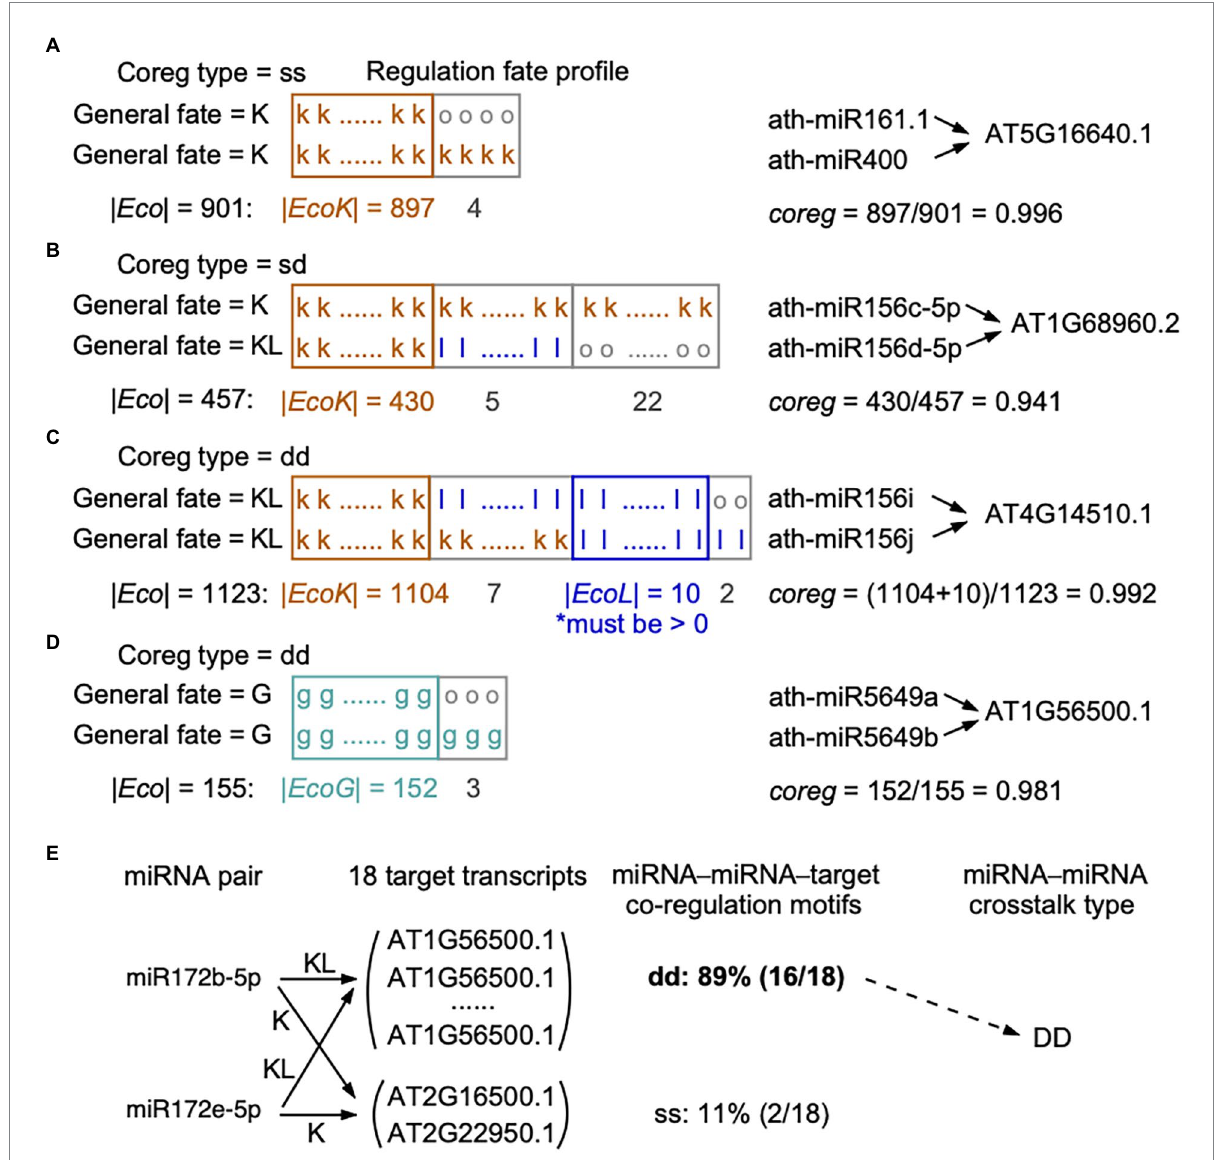
FIGURE 1 Calculation of co-regulation ( coreg ) score based on the regulation fate profiles. (A-D) Four different conditions for calculating coreg score were presented. When two miRNAs co-regulate a certain target in the reference genome, loss events in some ecotypes may happen (A) to none regulatory pairs (their general fates as “K” and “K”), (B) to only one regulatory pair (“K” and “KL”), or (C) to both regulatory pairs (“KL” and “KL”). (D) Two miRNAs may gain a common target in some ecotypes but the two regulatory pairs are not present in the reference genome (the general fates as “G” and “G”). In regulation fate profiles, the fate in each ecotype is “k,” “l,” “g,” or “o”. A miRNA–target regulation marked with the fate as “o” in an ecotype means this regulation was detected by only one miRNA target prediction tool in this ecotype. We required that in (C) , EcoL , the set of ecotypes, in which the two regulatory pairs are lost, should not be empty, to make sure the two regulatory pairs were dropped together in at least one ecotype. The co-regulation type of a miRNA–miRNA–target motif (“ss”: static-static, “dd”: dynamic-dynamic, and “sd”: static-dynamic) was defined according to the general fates of the two regulatory pairs (see Materials and methods). (E) An example showing the definition of the crosstalk type for a cooperative miRNA pair. Ath-miR172b-5p and ath-miR172e-5p target 18 common transcripts, 11% (2 out of 18) of transcripts are targeted with the co-regulation type of ss and 89% (16 out of 18) of transcripts are targeted with the co-regulation type of dd. We considered that ath-miR172b-5p and ath-miR172e-5p cooperatively interact with DD as the crosstalk type, because more than half of the common targets are co-regulated with the co-regulation type of dd (see Materials and